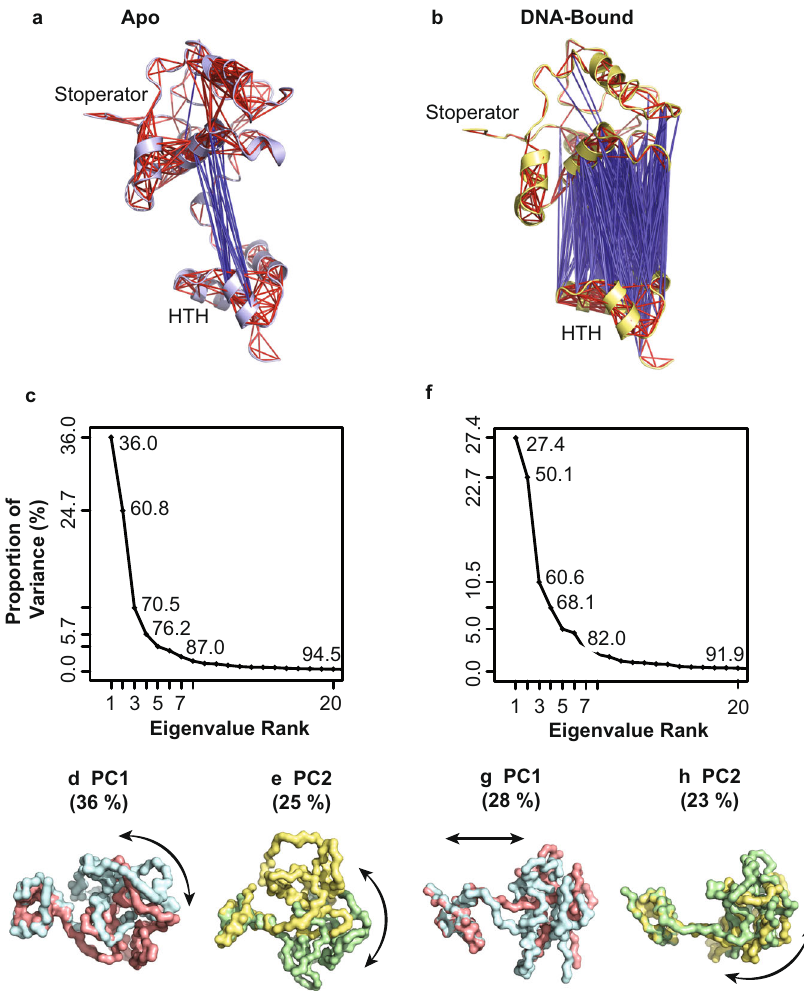
Fig. 5 DNA binding promotes altered conformational dynamics. a , b Cross-correlation analysis indicates a combination of positively (blue rods) and negatively (red rods) correlated conformational motions for the apo ( a , slate blue) versus DNA-bound ( b , yellow) TipsytheTRex repressor structure.